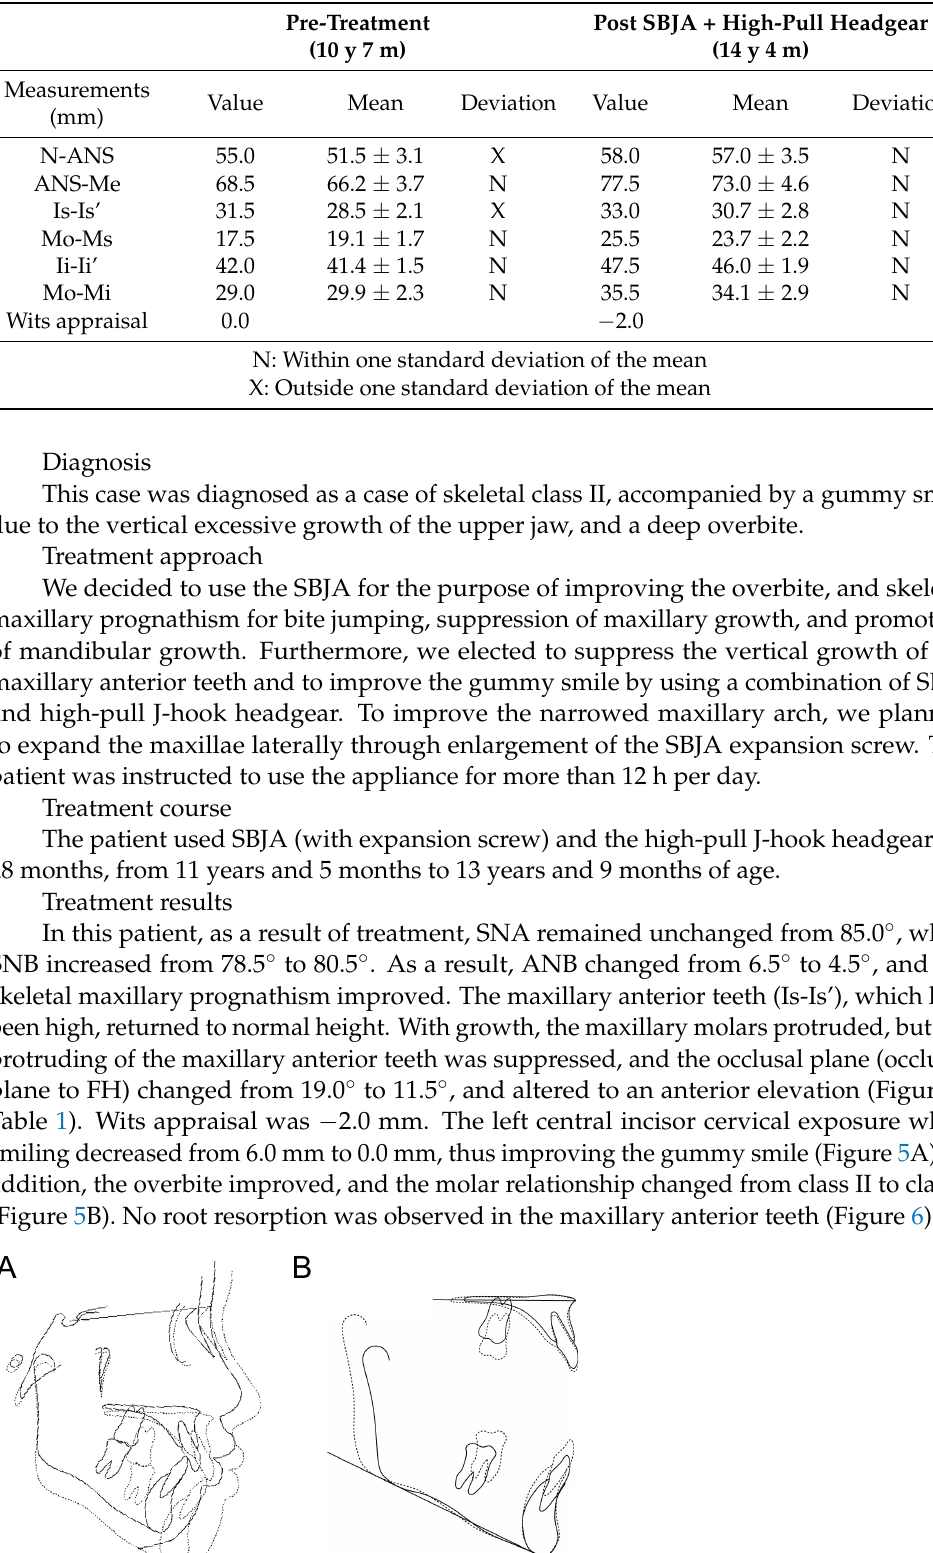
Figure 5. Facial photograph and intra-oral photograph of Case 1 at the end of the first stage of treat- ment; facial photograph and enlarged photograph of the mouth at the end of the first stage of treat- ment ( A ); intra-oral photograph at the end of the first stage of treatment ( B ).